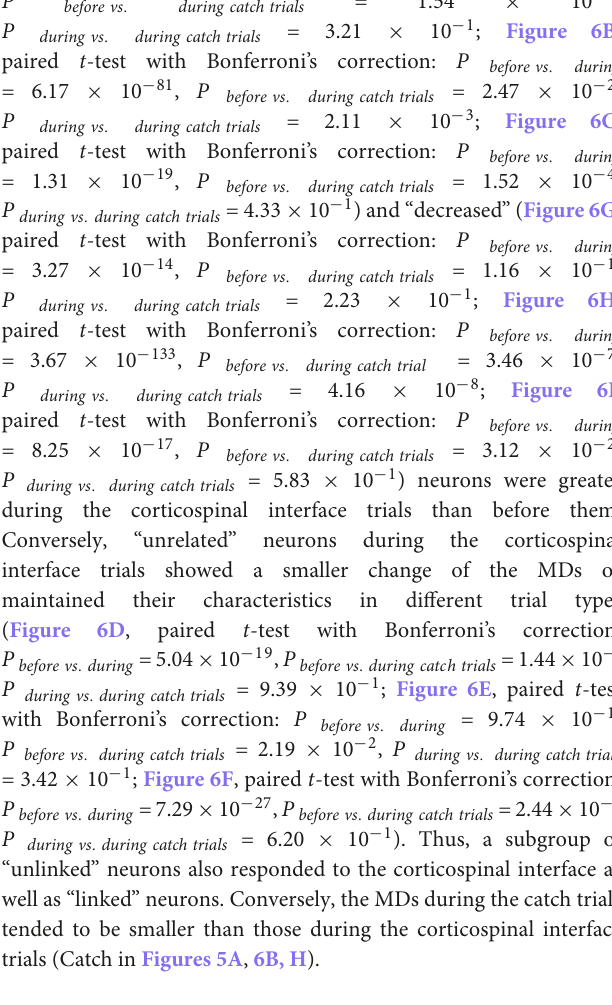
P = 1.04 × 10 − 11 ), and the MDs of EMG and torque in the “Strong” torque trials were also significantly greater than those of the “Weak” torque trials (EMG in Figure 7C , paired t -test: P = 1.26 × 10 − 46 ; wrist torque in Figure 7D , paired t -test: P = 6.39 × 10 − 10 ). There was no significant difference in task performance between the “Weak” and “Strong” torque trials ( Figure 7E , paired t -test with Bonferroni’s correction: P before vs . in weak torque trials = 5.36 × 10 − 16 , P before vs . in strong torque trials = 2.33 × 10 − 16 , P in weak torque trials vs . in × 10 − 2 , P strong torque trials = 5.05 in weak torque trials vs . during catch trials = 5.36 × 10 − 16 , P in strong torque trials vs . during catch trials = 2.33 × 10 − 16